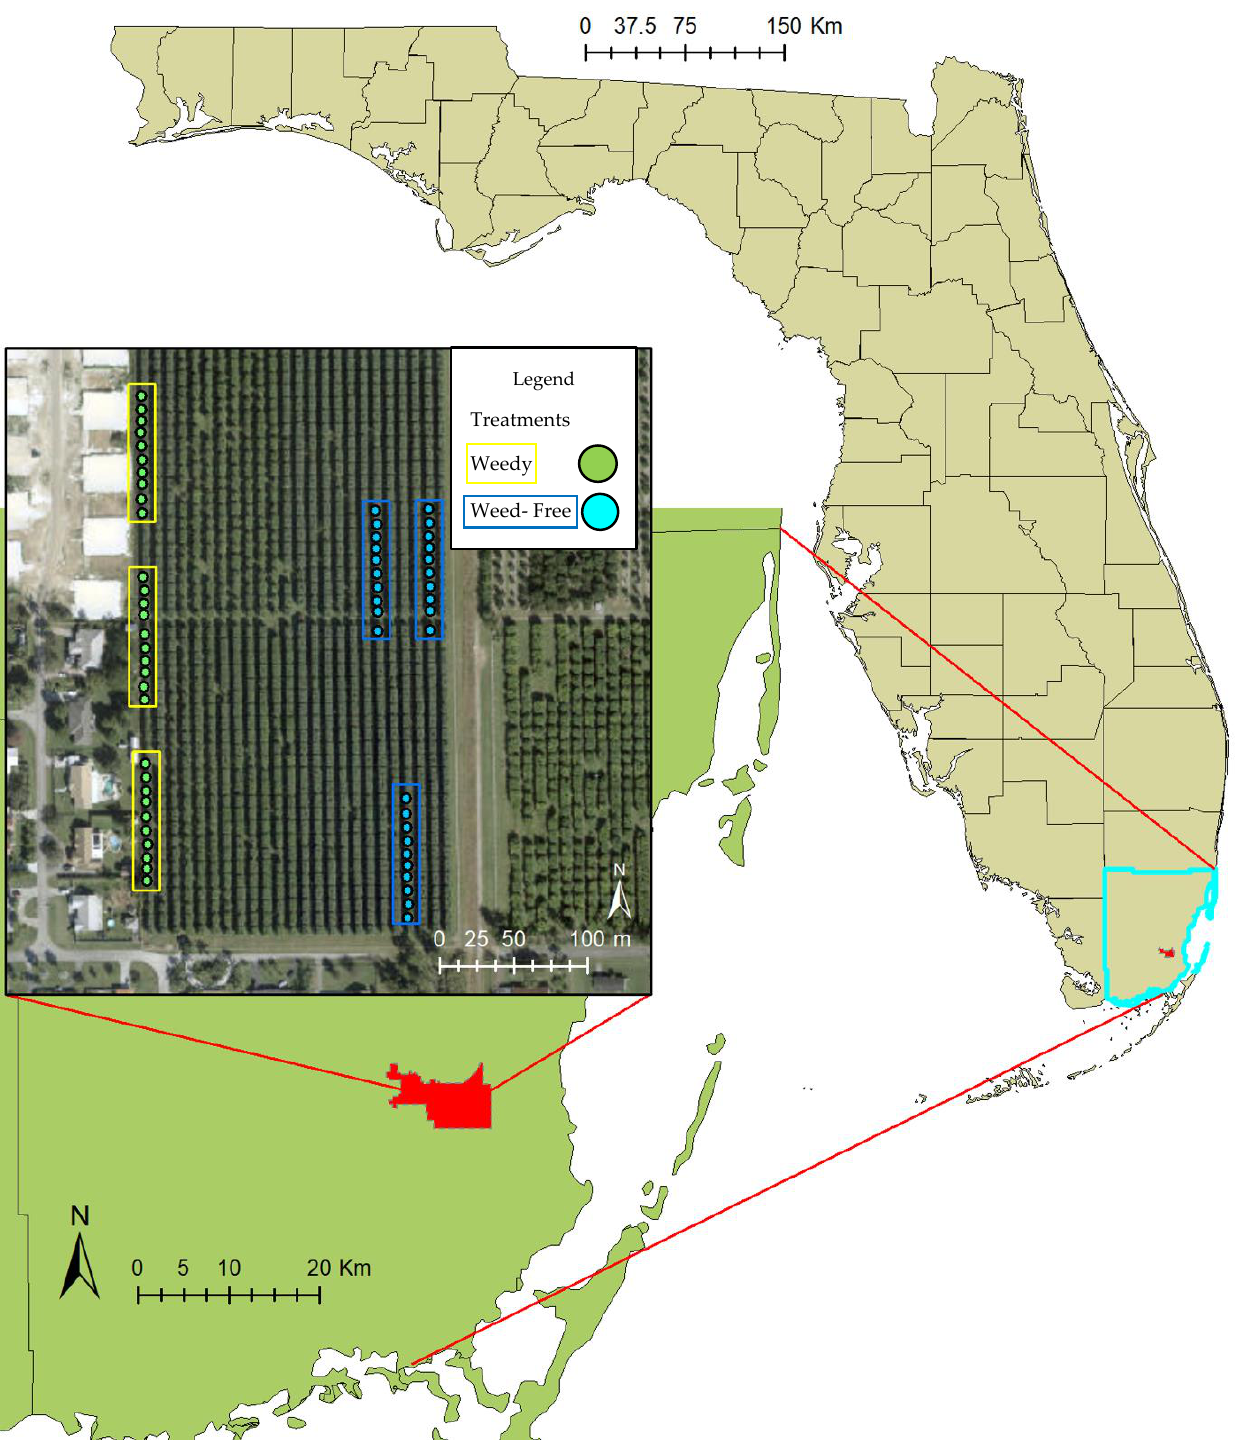
Figure 2. Location of the study site in southern Florida, USA, with location of farm and treatments within the mango grove indicating weedy and weed-free trees. Locations of plots were dictated by farm management practices.